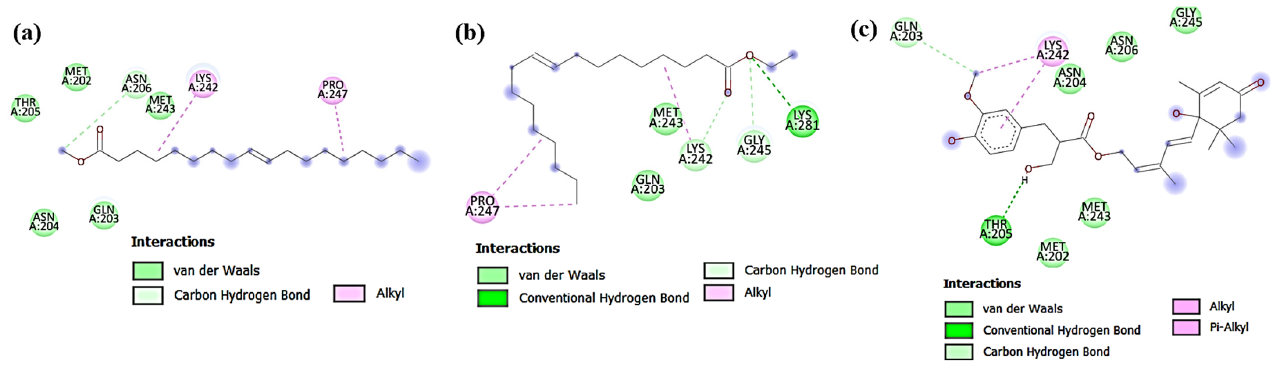
Figure 6. Two-dimensional (2D) molecular interactions of ( a ) Compound C1 and ( b ) C2 , and ( c ) C5 with β -catenin (PDB ID:7AFW), (dimensions (Å); X:20.4162, Y: 21.1198, Z:25.0), (root mean square deviation) RMSD < 2.